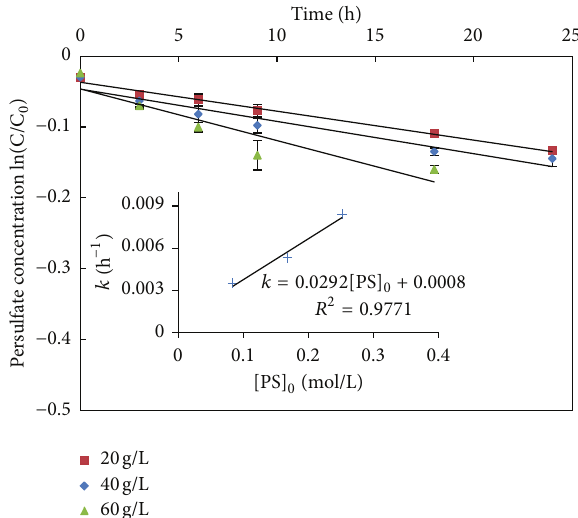
Figure 2: The decomposition of persulfate in the reactive system.